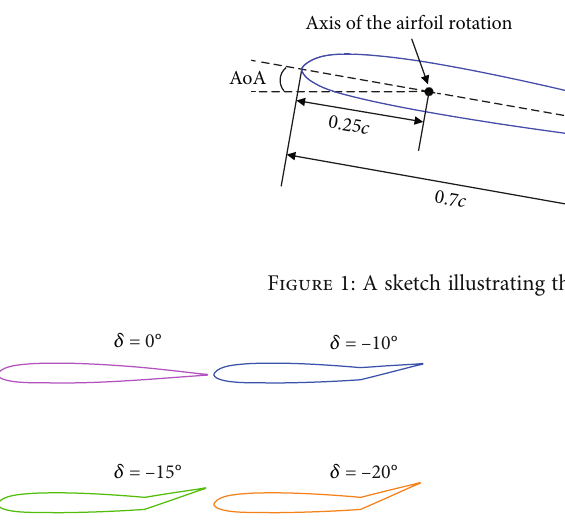
Figure 2: Geometry shapes of the airfoil at di ff erent de fl ection angles.